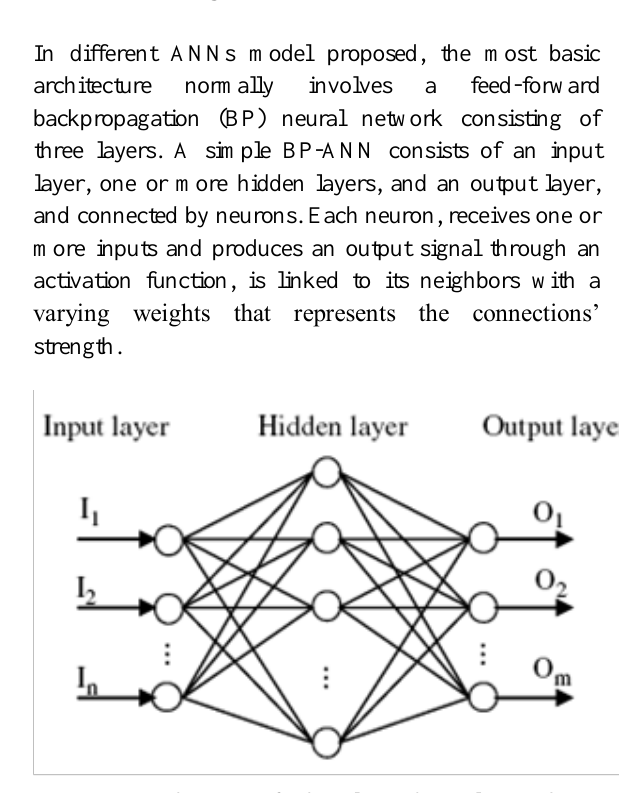
Fig. 2.1 Architecture of a three-layered neural